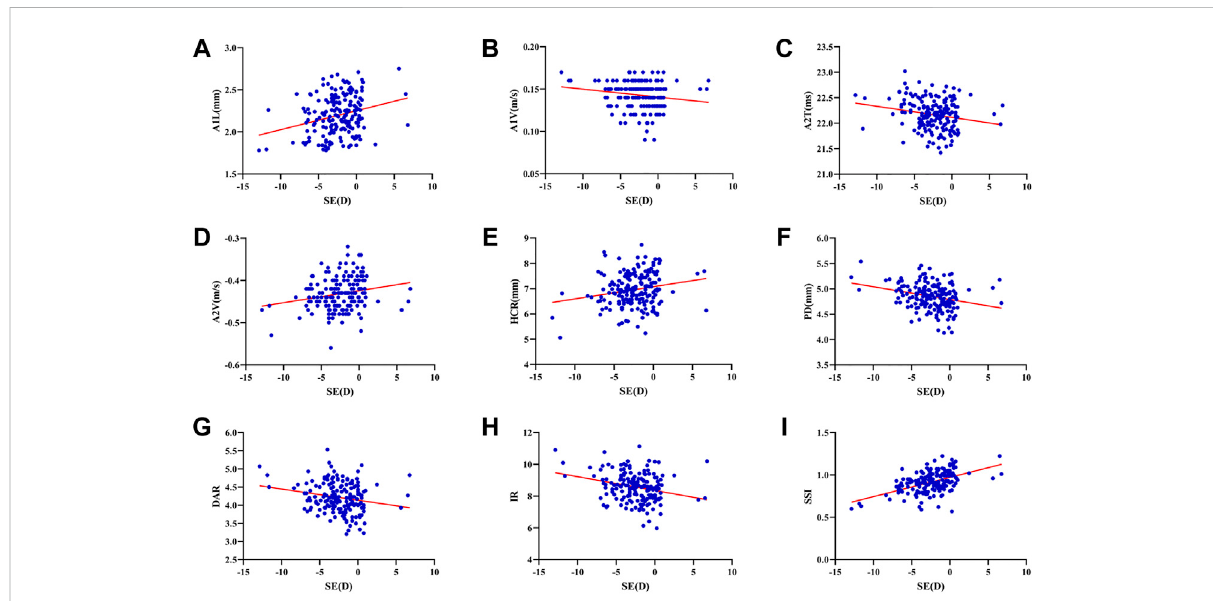
FIGURE 1 Corneal biomechanical parametersweresigni fi cantly correlatedwiththerefractiveerror. SEhadsigni fi cantcorrelations withA1L( r =0.260, p < 0.001) (A) , A1V ( r = -0.174, p = 0.020) (B) , A2T ( r = -0.201, p = 0.007) (C) , A2V ( r = 0.208, p = 0.005) (D) , HCR ( r = 0.198, p = 0.008) (E) , PD( r = -0.271, p < 0.001) (F) , DAR ( r = -0.206, p = 0.006) (G) , IR ( r = -0.264, p < 0.001) (H) and SSI ( r = 0.501, p < 0.001) (I) (Panel 1A – I).